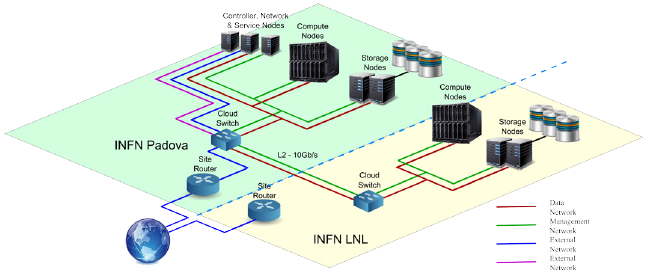
Figure 1. The architecture of the Cloud Area